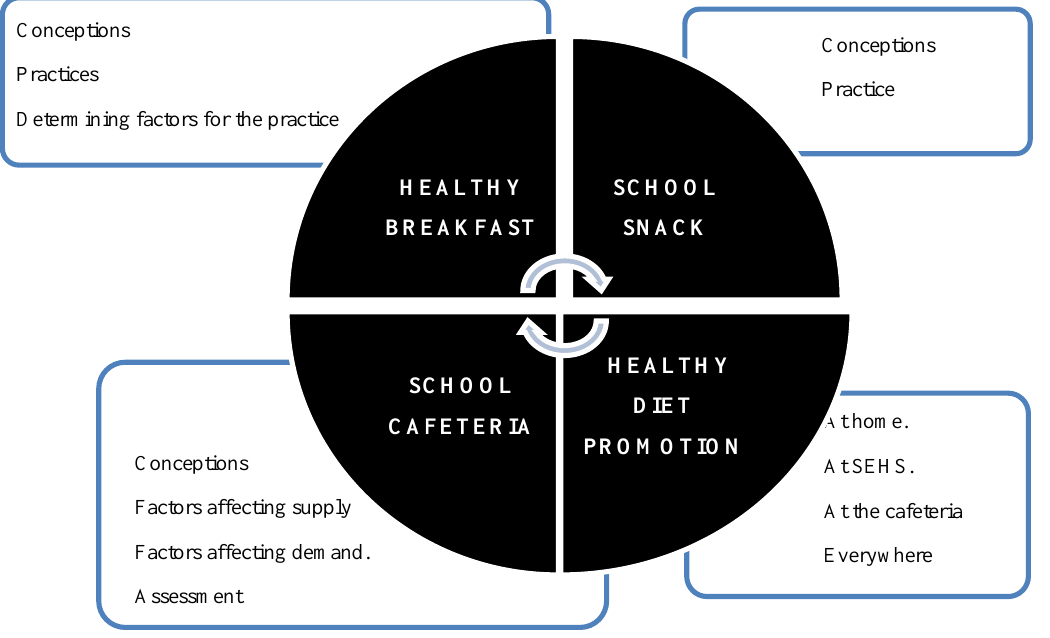
Figure 1. Study categories. Source: Self-prepared;